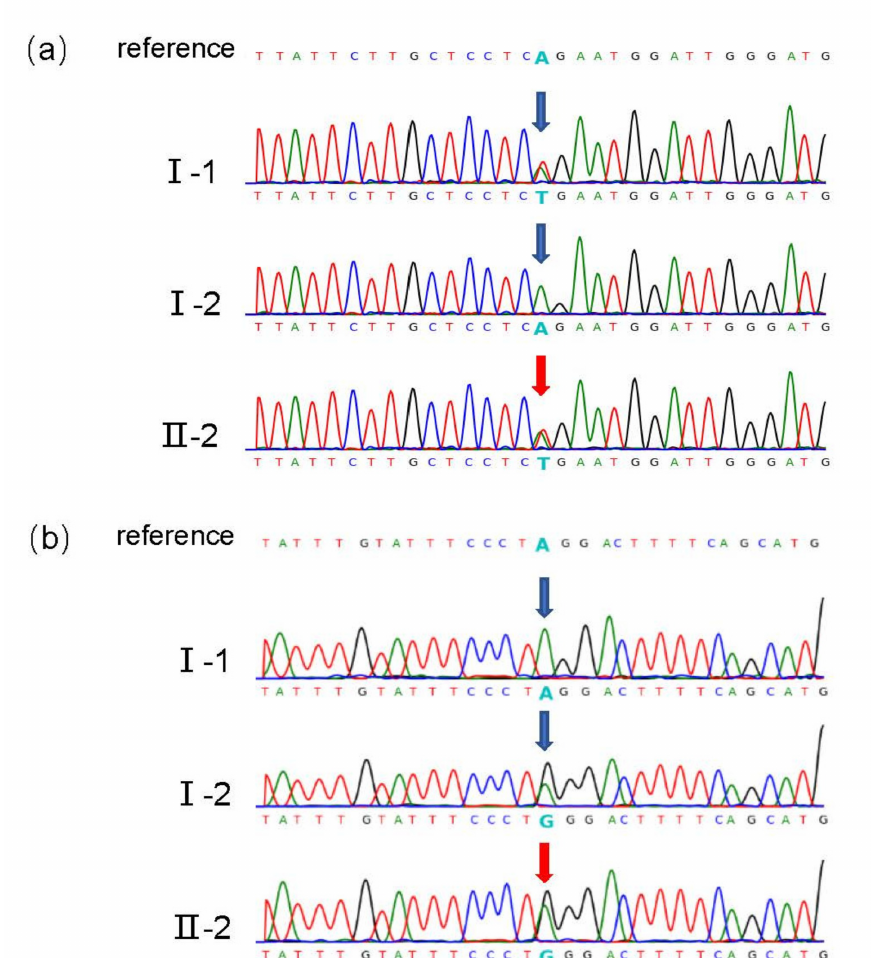
Figure 2. Sanger sequencing chromatogram of KIAA0825 variants in the family. ( a ) The variant c.-1-2A>T in KIAA0825 is identified in II-2 (proband) and I-1 (father). Arrows represent the variant. ( b ) The variant c.2247-2A>G in KIAA0825 is identified in II-2 (proband) and I-2 (mother). Arrows represent the